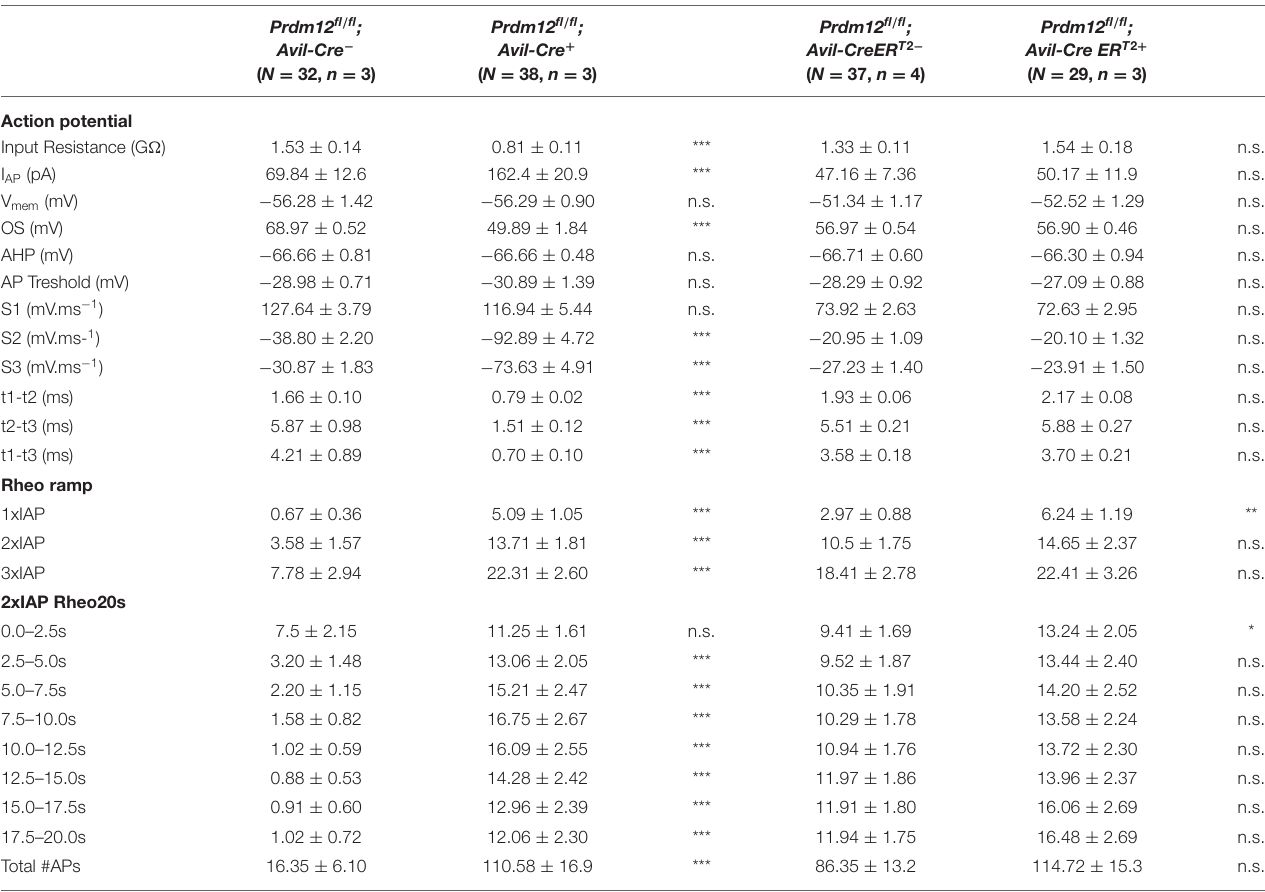
TABLE 3 | Action potential (AP) characteristics of Prdm12 fl / fl ; Avil-Cre + and Prdm12 fl / fl ; Rosa26-CreER T 2 + nociceptive neurons and corresponding